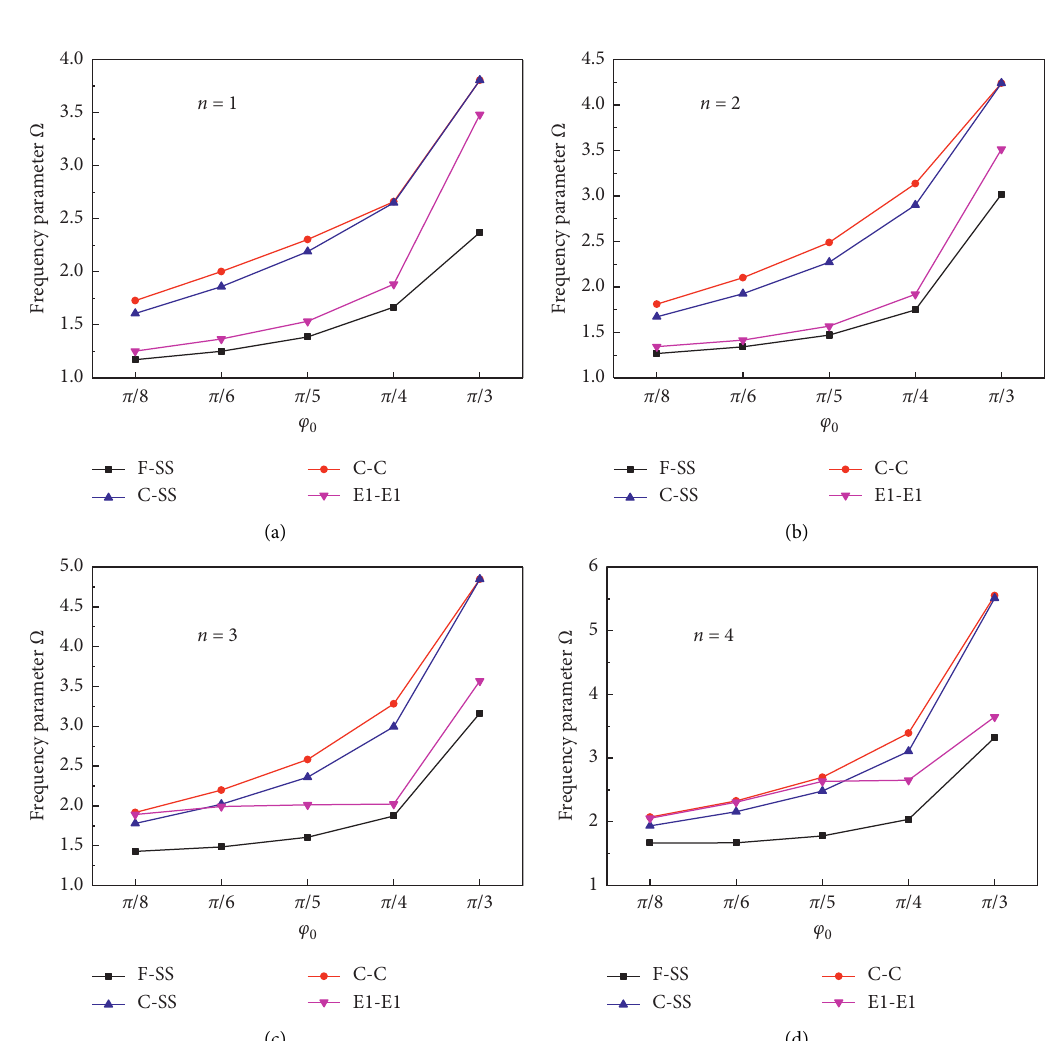
Figure 9: Frequency parameters Ω of the annular spherical shell with different φ